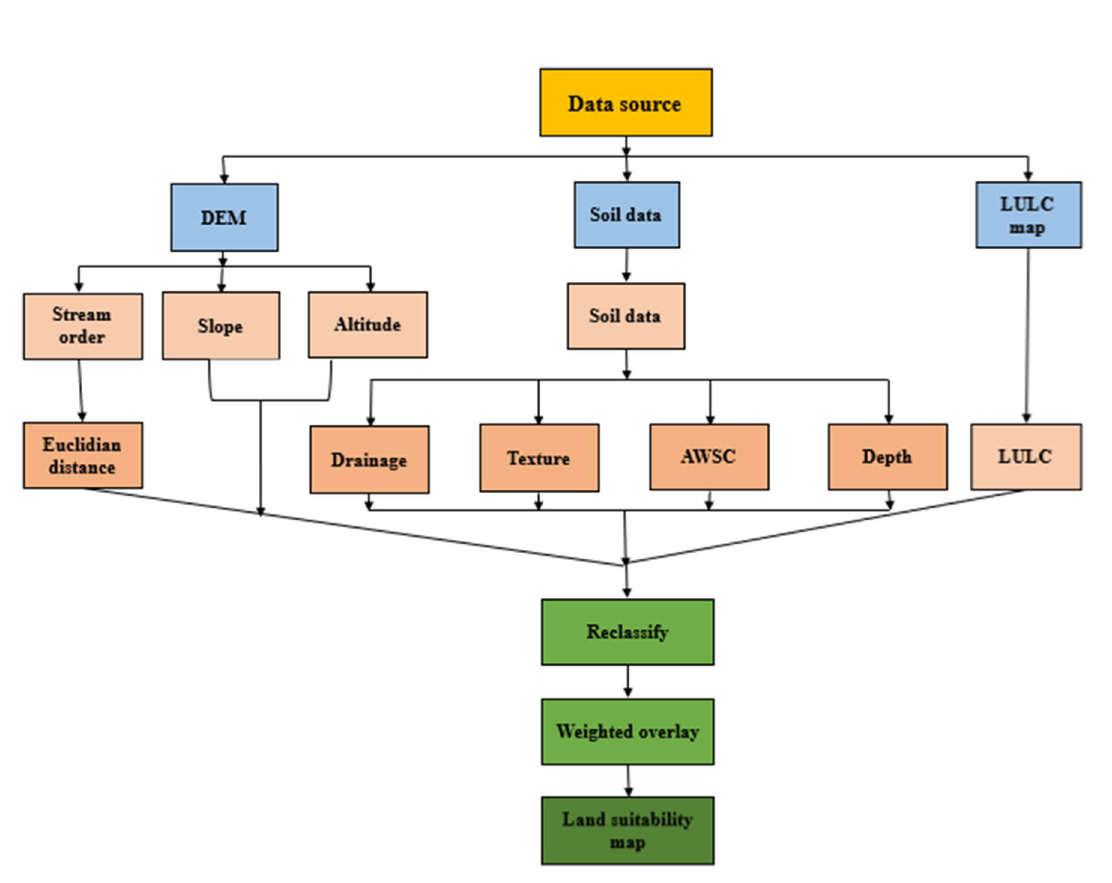
Fig. 2 Overall Conceptual Framework used in the